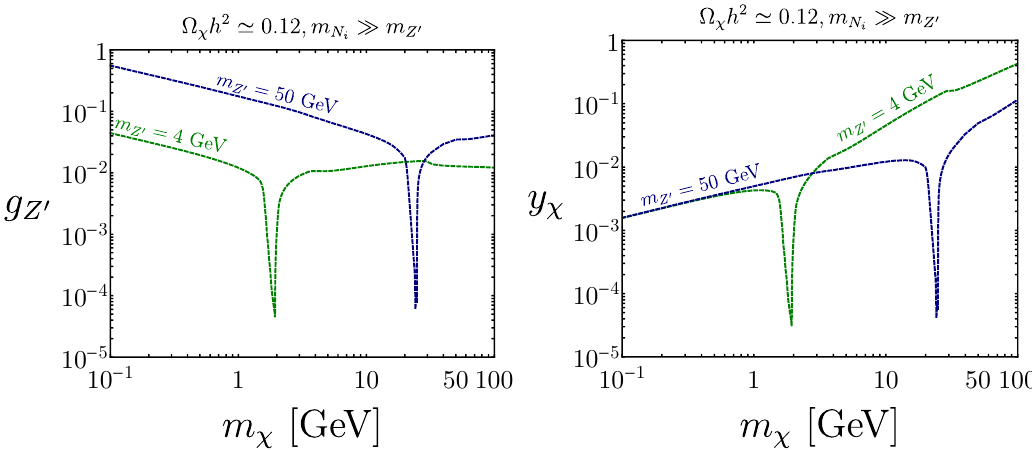
Figure 1 . Gauge coupling of the dark sector (left) and DM Yukawa coupling (right) as a function of the DM mass satisfying the relic density condition, computed numerically using micrOMEGAs [109]. Masses for the heavy neutrinos are taken to be m N = 30 GeV for m Z 0 = 4 GeV and m N = 300 GeV i i for m Z 0 = 50 GeV. Values of the various couplings are computed for each set of parameters g Z 0 and m (cid:31) , assuming m (cid:30) = v (cid:30) and mixing angles to be